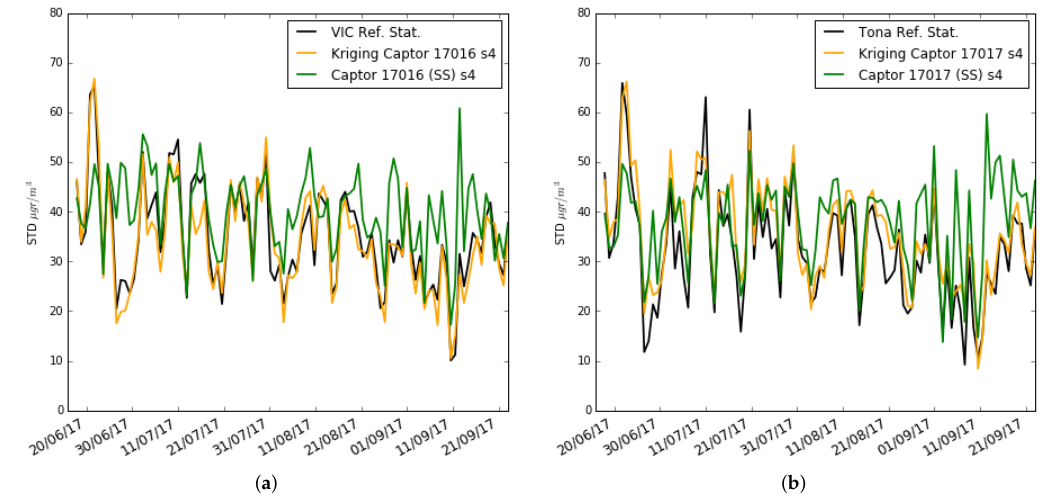
Figure 18. Case 3: Training set of 3 weeks: Standard deviation (STD) ozone concentration for single-scale versus multi-scale with exact correction and Kriging estimation (daily), ( a ) in Captor 17016 (Vic), ( b ) in Captor 17017 (Tona).